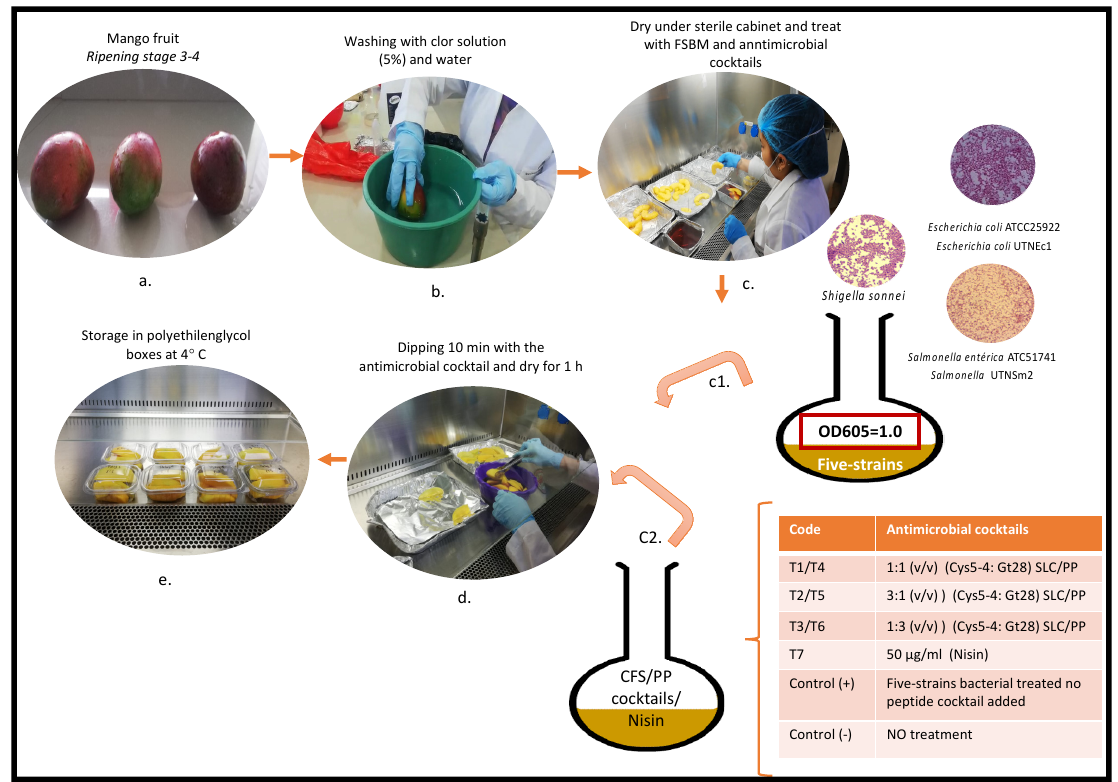
Figure 1. Treatment of mango wedges with antimicrobial cocktails. ( a ) mango fruits at stage 3-4 of ripening; ( b ) washing and disinfection; ( c ) submersion of wedges with the five-strain bacterial mixture ( c1 ) and dipping with antimicrobial cocktails ( c2 ): ( d ) drying; ( e ) storage in polyethyleneglycol boxes.